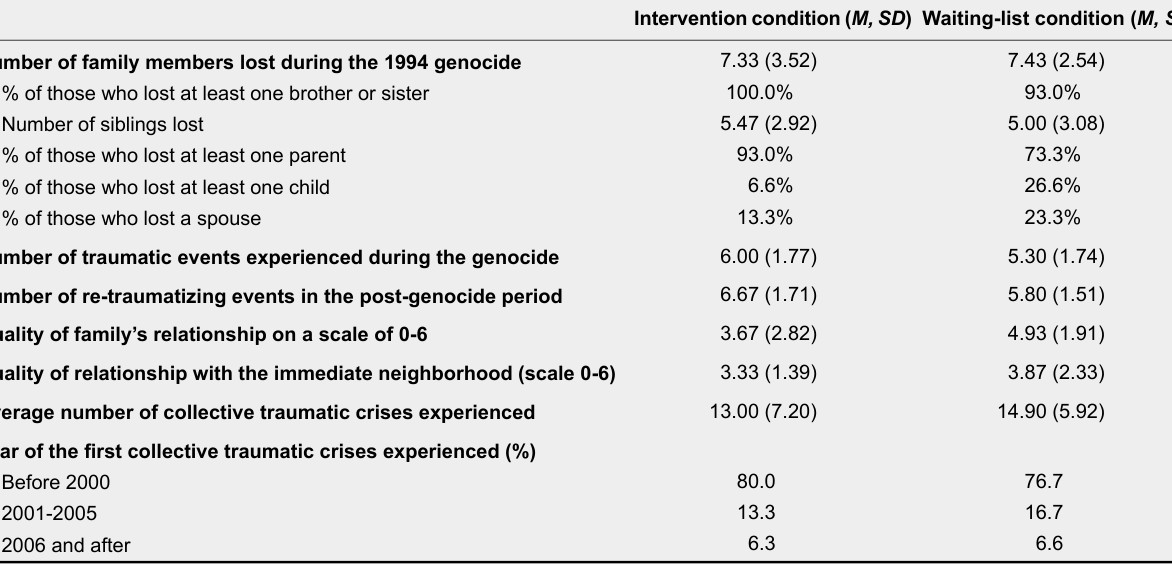
Waiting-list condition ( M, SD )Intervention condition ( M, SD